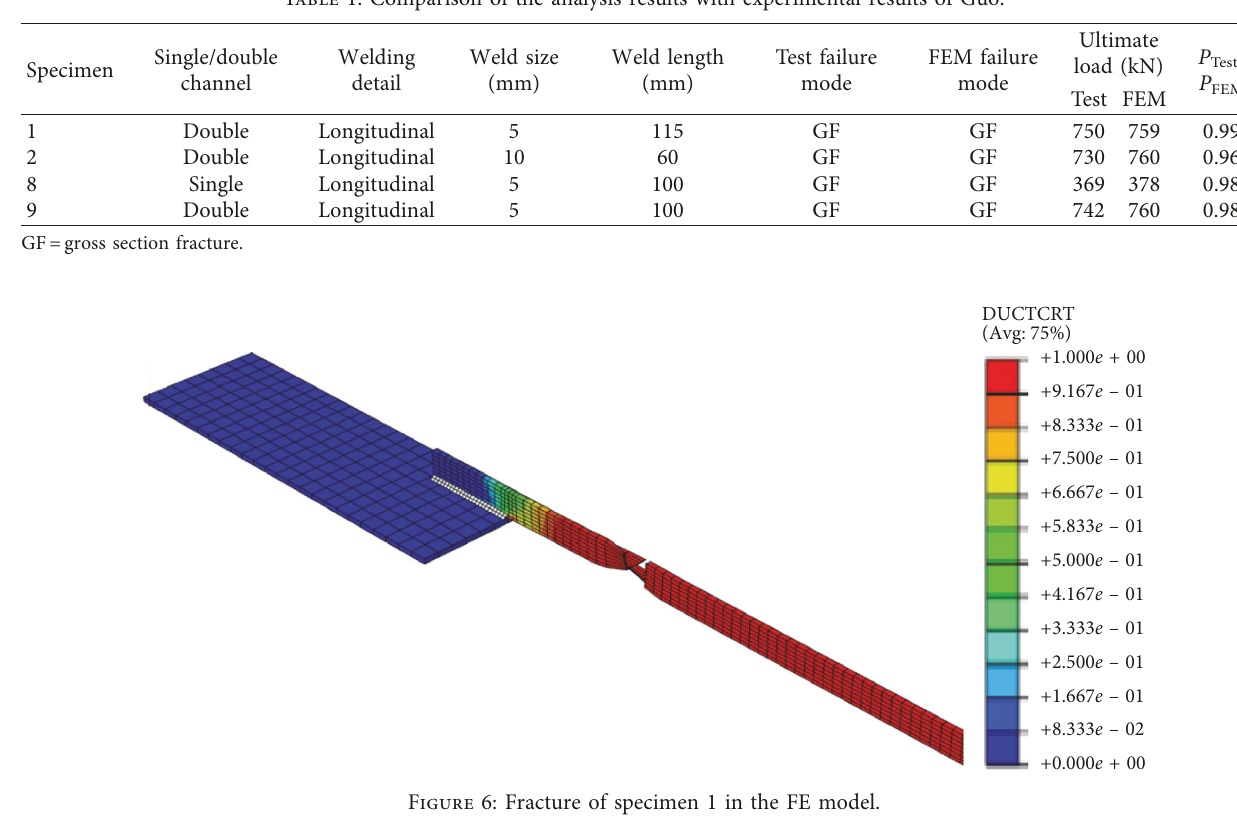
Table 1: Comparison of the analysis results with experimental results of Guo.